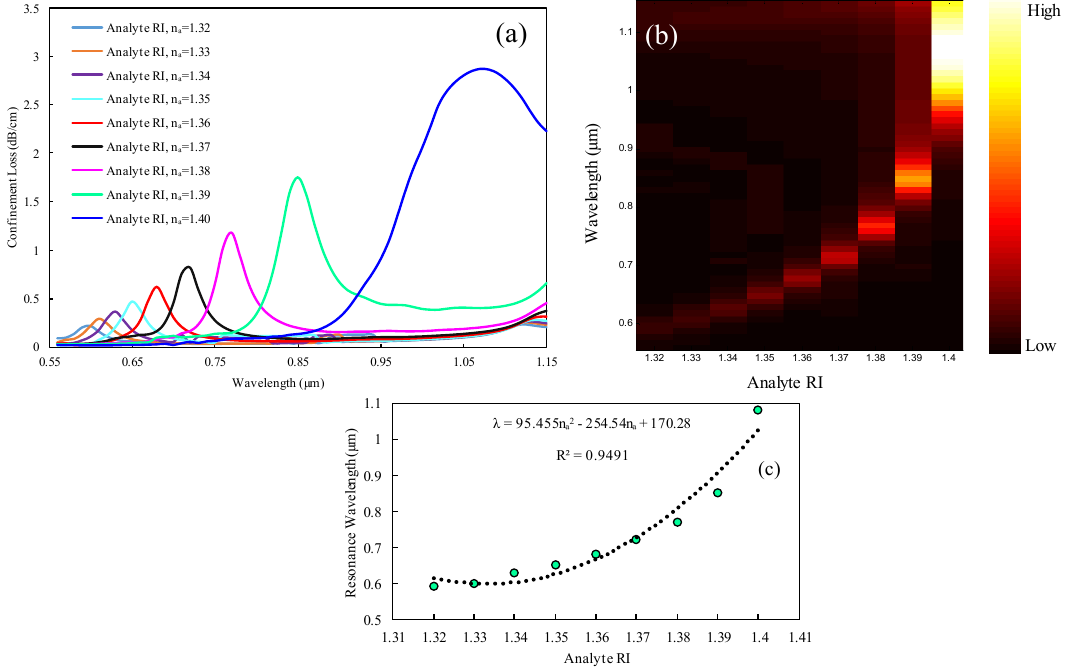
Figure 4. ( a ) Confinement loss spectra, ( b ) normalized resonance intensity, and ( c ) polynomial fitting characteristics for analyte RIs variation from 1.32 to 1.40.